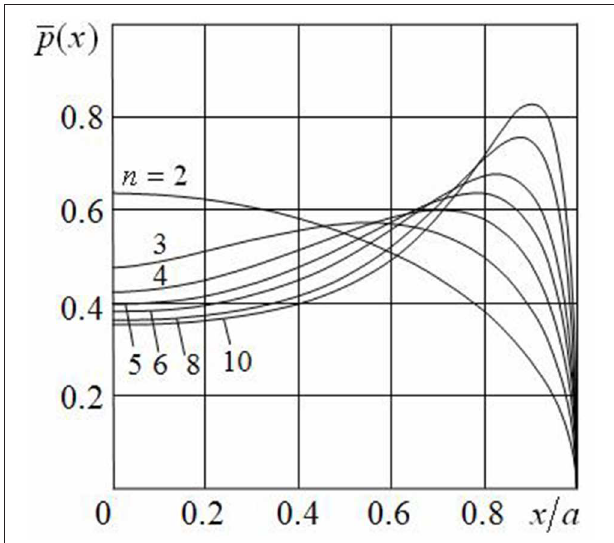
FIGURE 5 | Distribution of contact pressure